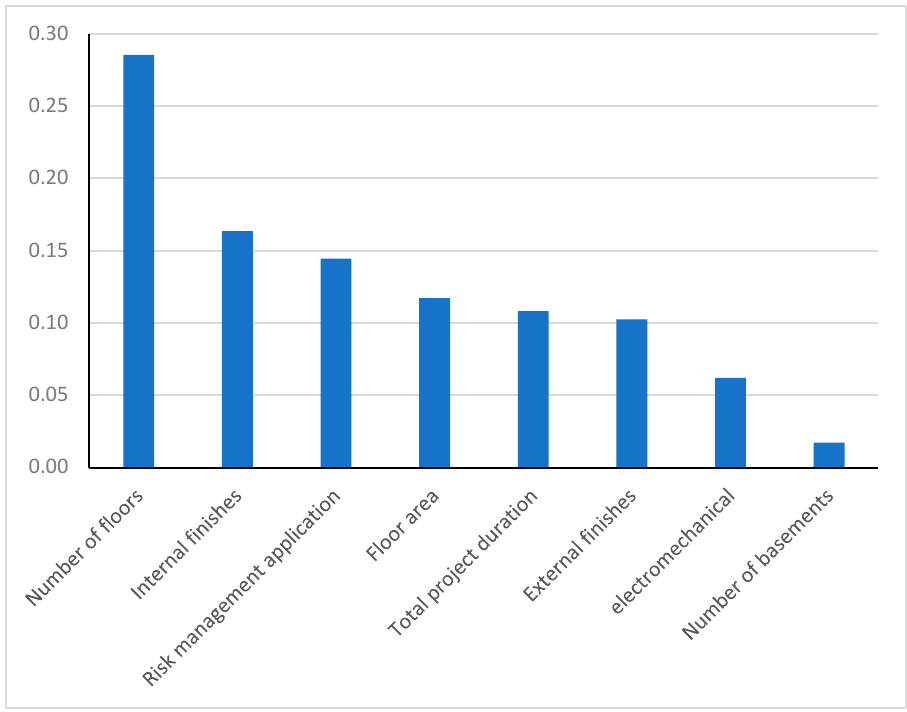
Figure 2. Importance of parameters in estimating the overall risk.